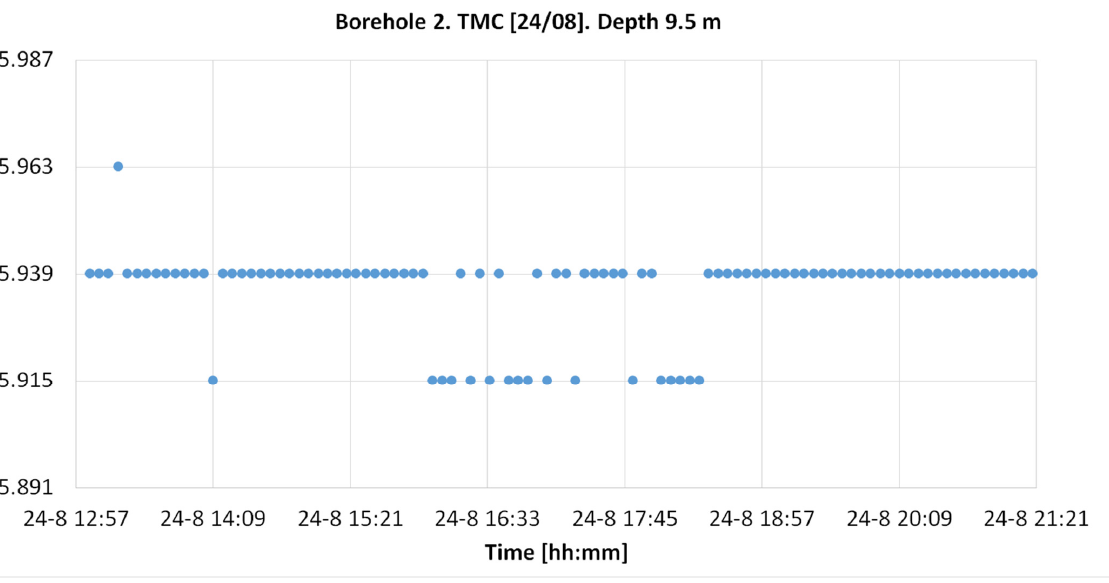
Figure 29. Temperature register on 24 August in the “Q-Thermie-Uniovi.2” borehole with TMCx-HD sensor at 9.5